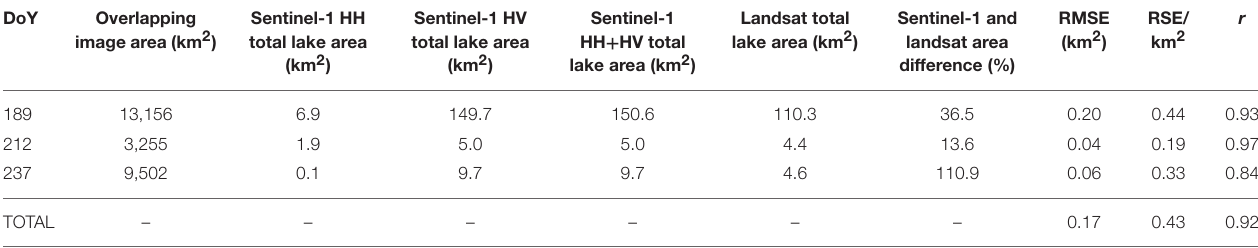
TABLE 1 | Results from the Landsat and Sentinel-1 surface lake detection methods for the three days when there was overlapping imagery. DoY Overlapping Sentinel-1 HH image area (km 2 ) total lake